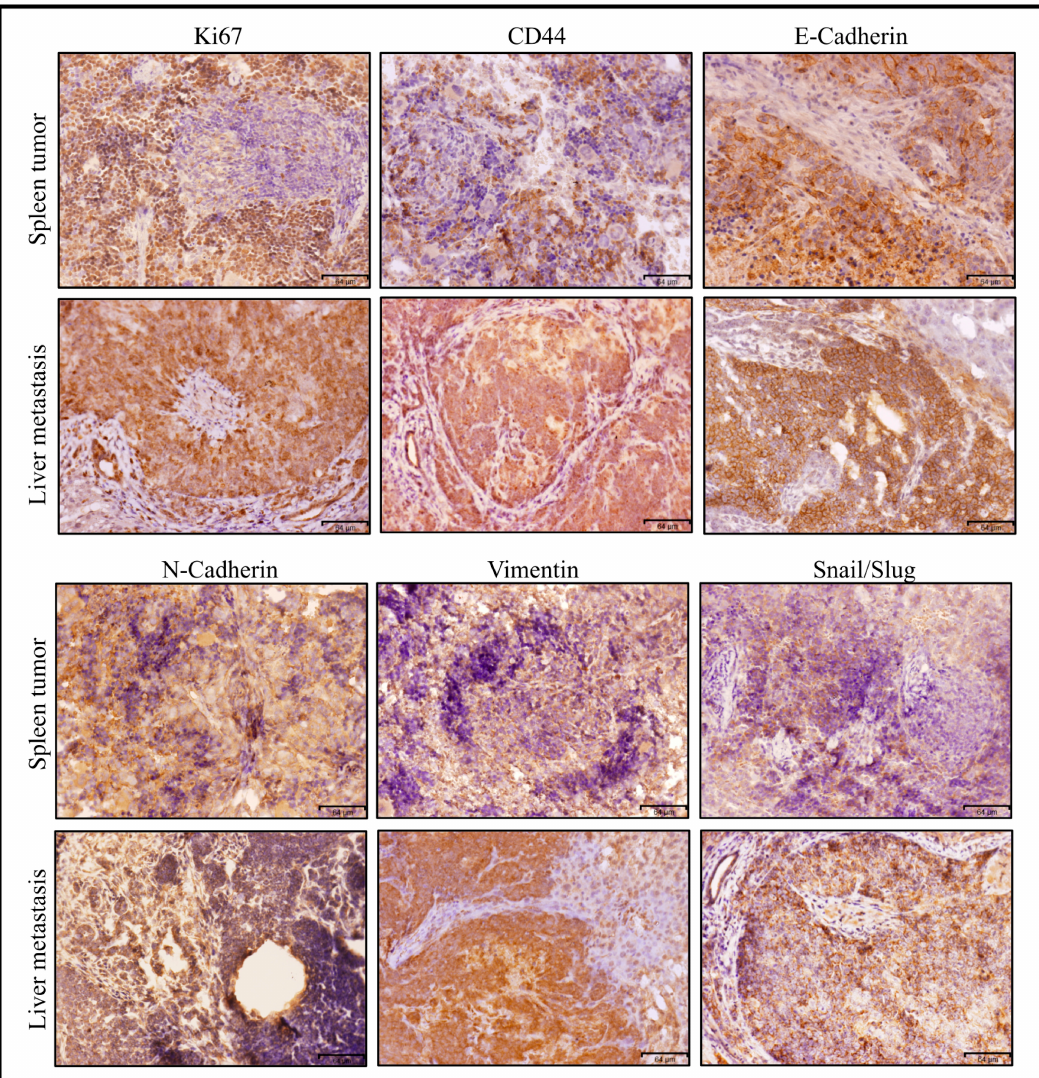
Figure 9. Immunohistochemistry of a miPS-Huh7cm cell-derived tumour in the spleen and liver—a metastatically developed tumor via intrasplenic injection, which is shown in Figure 6. The tissue section was stained with antibodies against CD44, Ki67, GFP, Vimentin, N-cadherin E-cadherin and Snail/Slug. Scale bars represent 64 μ m.